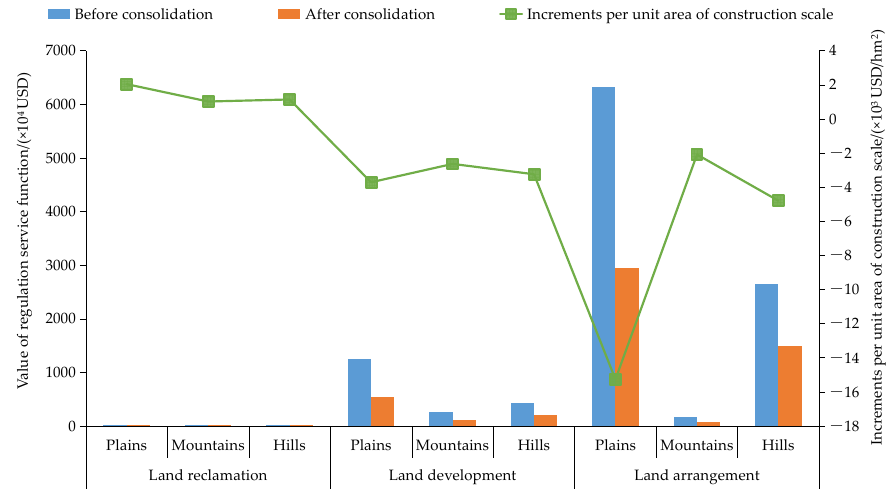
Figure 4. Change in value of regulation service function before and after consolidation in typical land consolidation project areas in Hubei province.